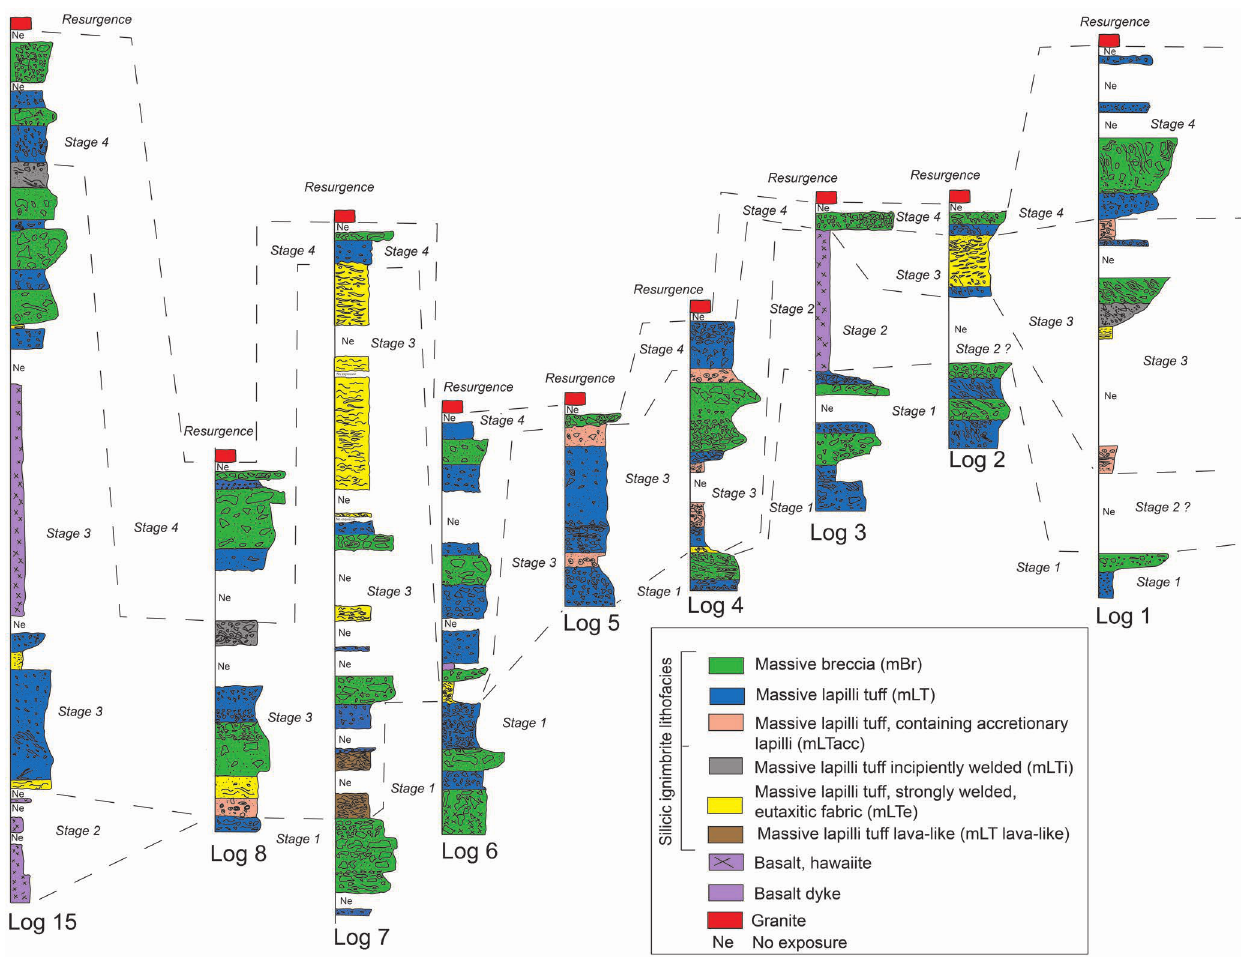
Figure 11: Correlation of logged sections (west). Proposed KVF eruption stages interpreted by correlation of logs 1–8 and 15 to West of Beinn Dearg Bheag (Figure 3). Generalised vertical scale shown may be reduced in regions of no exposure (for details of vertical scale within individual logs 1–8 and 15 refer to Supplementary Material 1 (logs